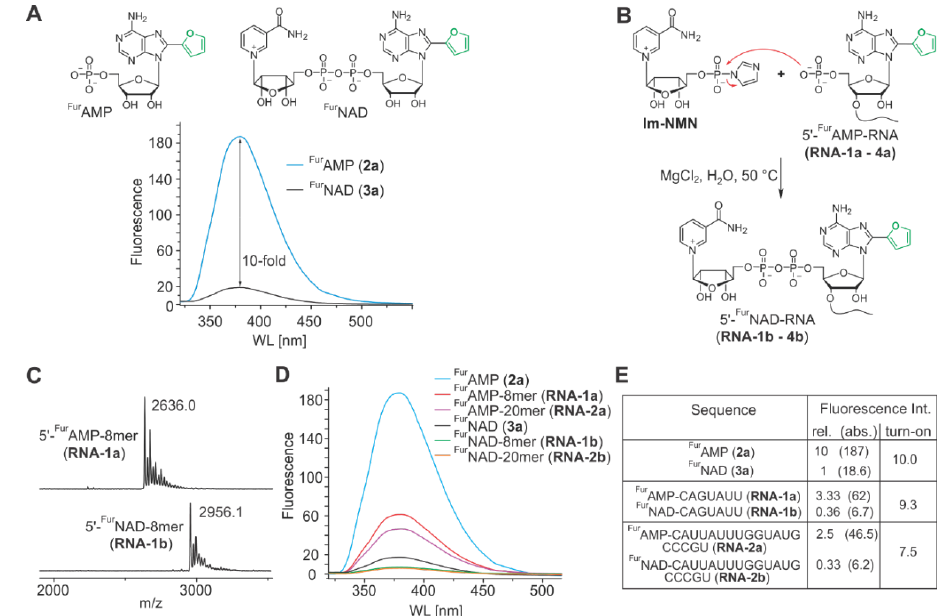
Figure 3. Synthesis and characterization of 8-(furan-2-yl)-NAD-RNAs. ( A ) Fluorescence properties of 8-(furan-2-yl)-AMP ( 2a ) and 8-(furan-2-yl)-NAD ( 3a ), with 10-fold higher fluorescence intensity for 2a . ( B ) Synthesis of 5’- Fur NAD-RNA ( RNA-1b–RNA-4b , sequences in Table S1) via coupling of 5’-P-RNA ( RNA-1a–RNA-4a ) with Im-NMN. ( C ) MALDI-MS of RNA-1a and RNA-1b ; m/z calculated for (M + H) + , 2640.4 (RNA-1a) and (M) + , 2956.4 ( RNA-1b ). ( D , E ) Sequence and fluorescence properties of 8-(furan-2-yl)-AMP-RNAs and corresponding 8-(furan-2-yl)-NAD-RNAs.